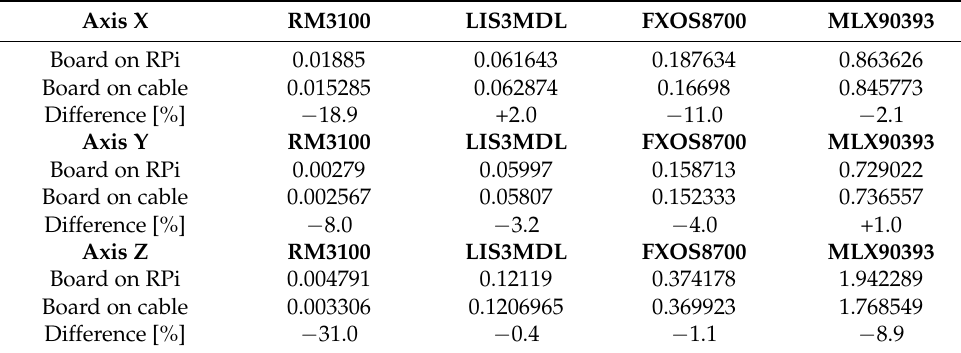
Table 2. Variance of noise for individual measurements [ µ T 2